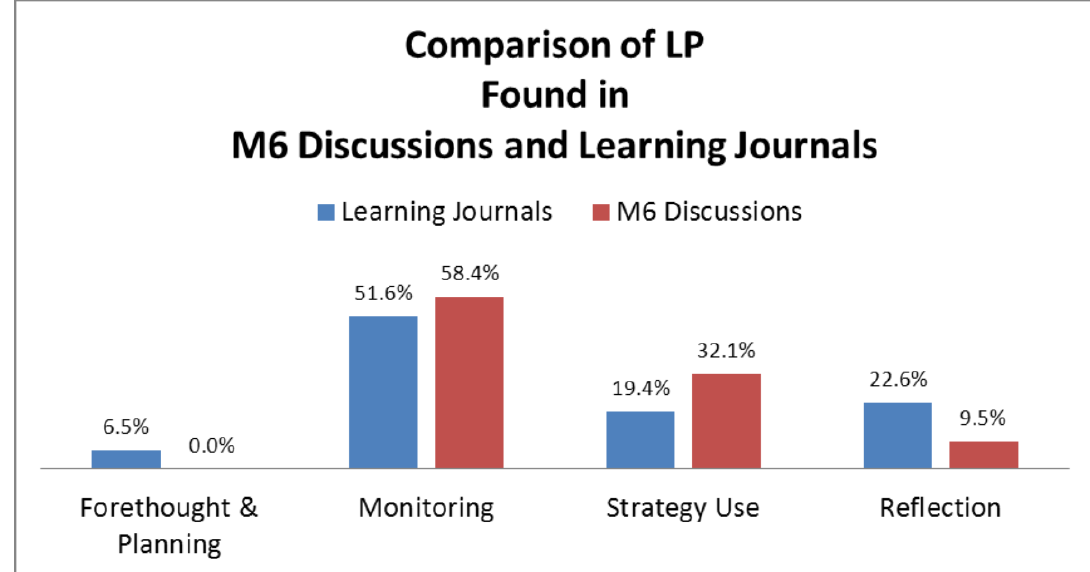
Figure 2 . Comparison of LP in all Module 6 learning activities